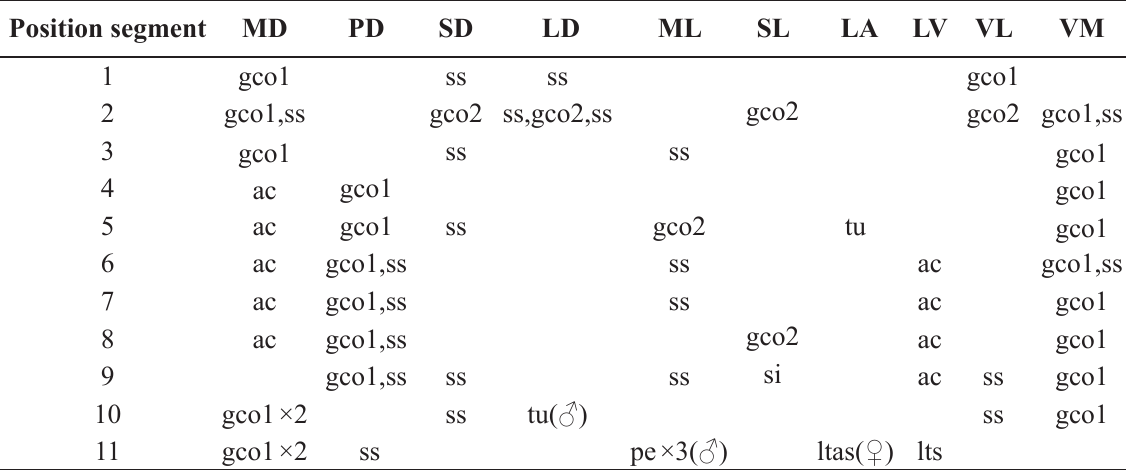
Table 21. Summary of nature and location of sensory spots, glandular cell outlets, tubes and spines arranged by series in Echinoderes galadrielae sp.